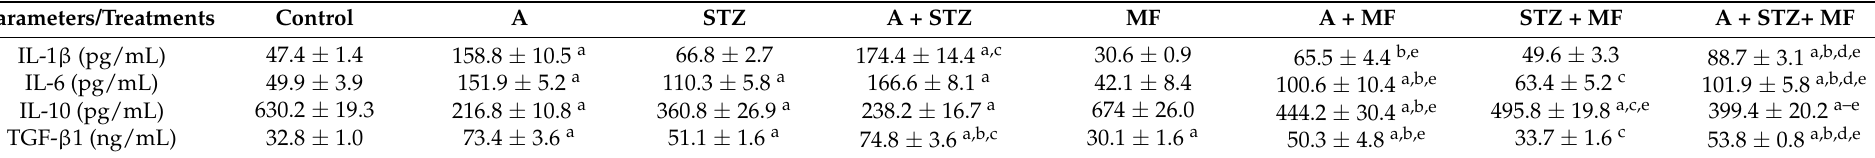
Table 4. Effect of metformin (MF) treatment on some plasma cytokines in diabetic and non-diabetic rats with adenine (A)-induced chronic kidney disease (CKD).